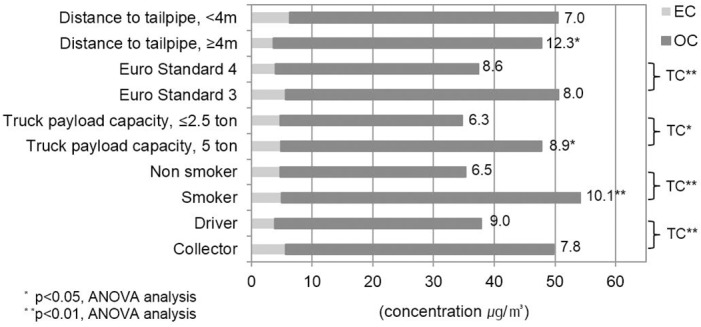
Geometric mean of TC and OC/EC according to job task, smoking habit, and type of truck.The geometric mean TC is presented as a bar chart. Each bar is the sum of EC (ivory bar) and OC (gray bar). The mean levels of TC for the collectors, smokers, workers on larger trucks and on trucks meeting Euro Standard 3 were significantly higher than those of the drivers, non-smokers, workers on smaller trucks, and those working on trucks meeting Euro Standard 4. The OC/EC is shown at the end of each bar. The OC/EC ratios for smokers, workers on larger trucks, and workers on trucks that had greater distances between the tailpipe and rear of the truck were significantly higher than those for the other categories of workers.